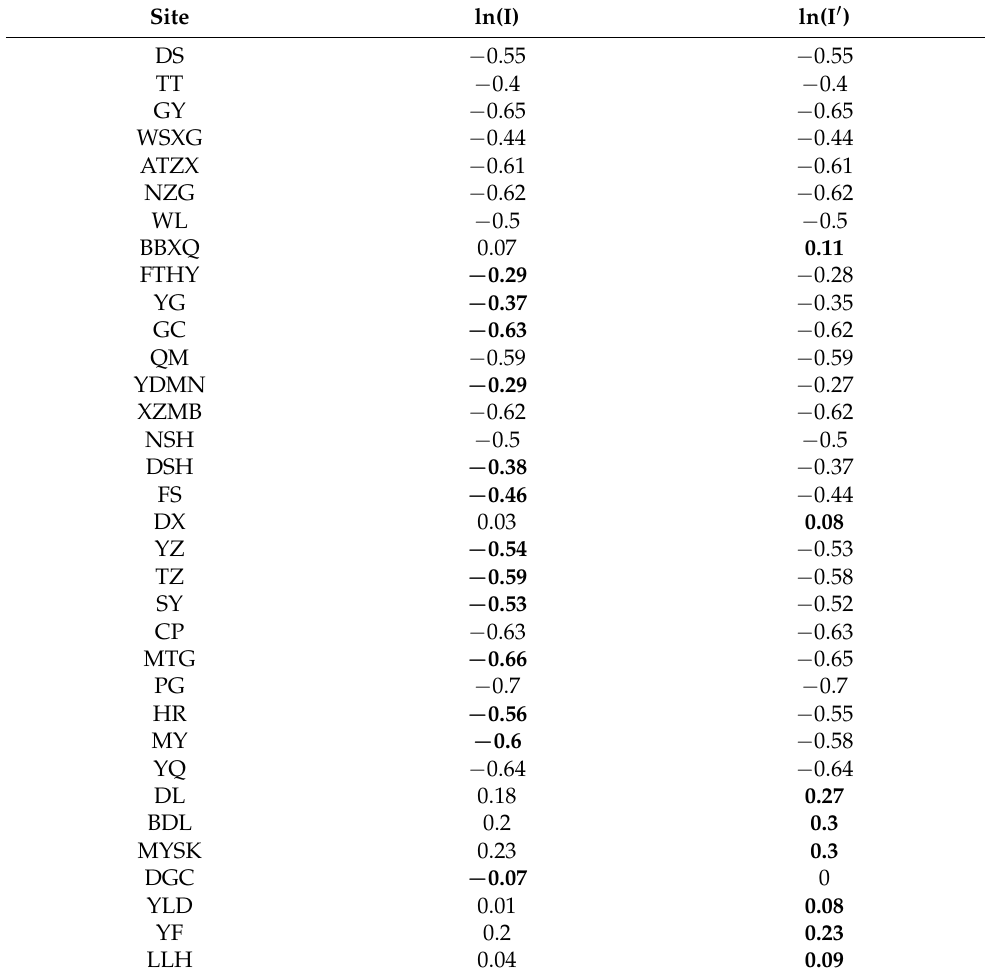
Table 7. Correlation coefficients between PM 2.5 / µ and ln(I), ln(I (cid:48) ) for 34 sites: ln(I (cid:48) ) is the natural logarithm of radiance after correcting